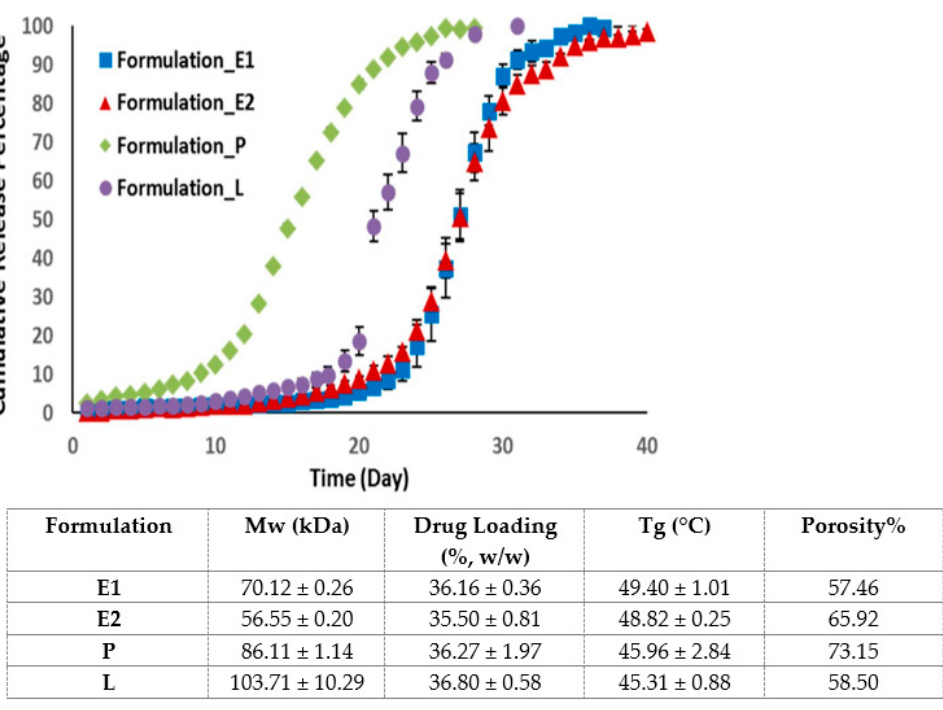
Figure 3. Drug release profiles of PLGA microspheres prepared under varying temperatures using emulsification solvent extraction/evaporation technique. High processing temperature results in a longer lag phase and a more pronounced sigmoidal drug release profile. (Reprinted from European Journal of Pharmaceutics and Biopharmaceutics , 81, Kerstin Vay, Wolfgang Frieß and Stefan Scheler, A